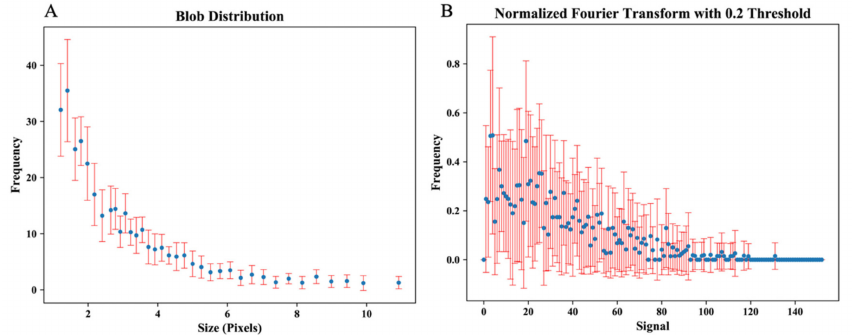
Figure 2. Blob size distribution, each color representing one eye of a subject ( A ). Normalized Fourier transform with 0.2 threshold; each color represents an eye ( B ).